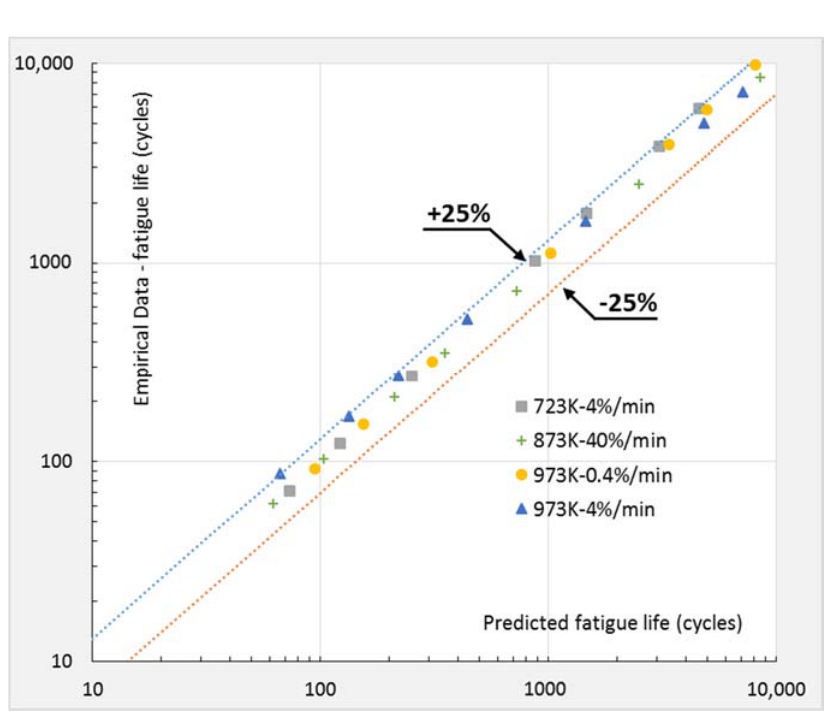
Figure 5. Prediction ratio for stainless steel 316.